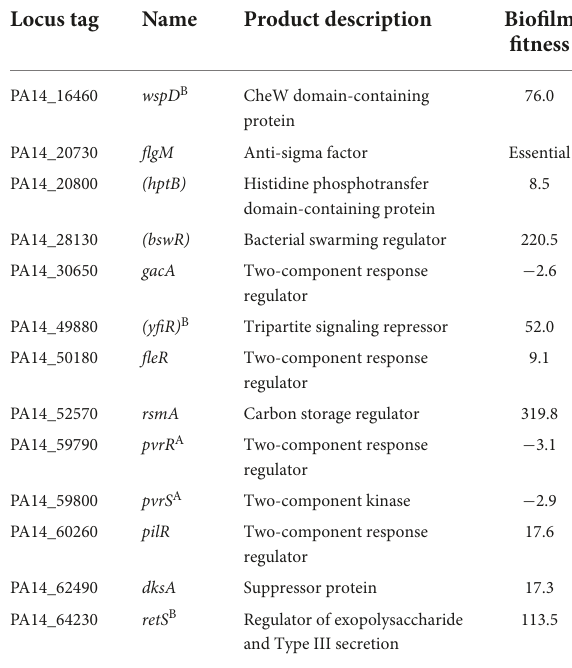
TABLE 1 Biofilm fitness phenotypes for selected